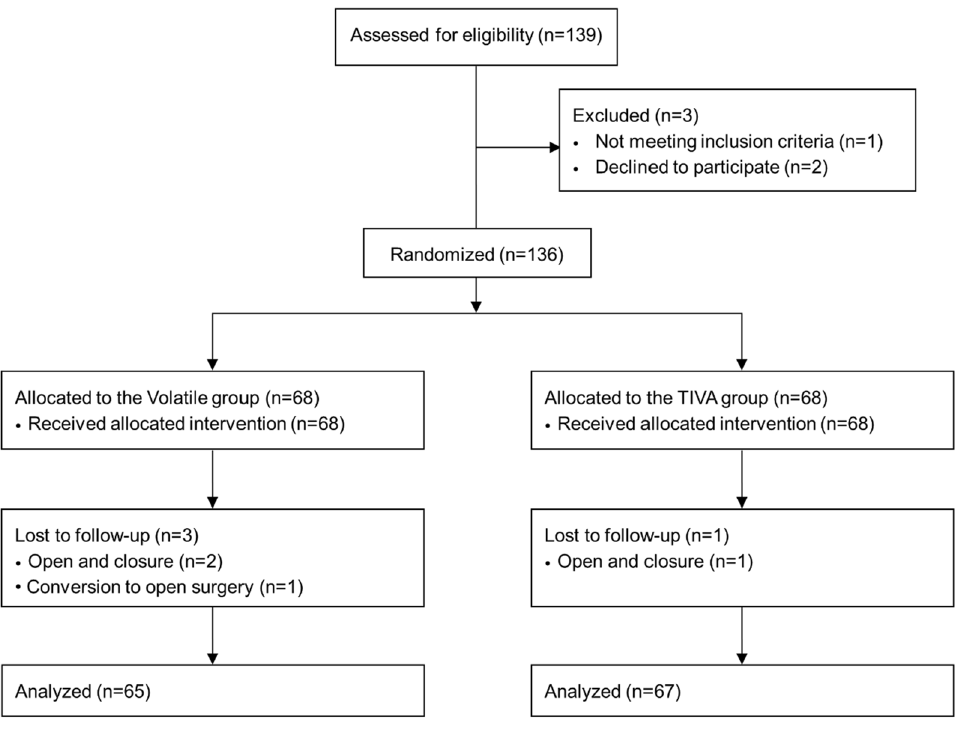
Figure 1. Consort flow diagram of the